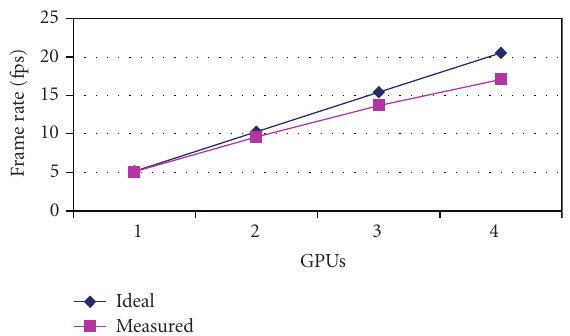
Figure 13: Ideal and measured speed up for up to 4 GPUs.